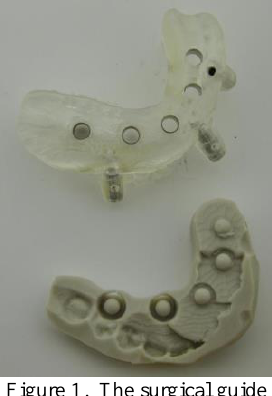
Figure 1. The surgical guide